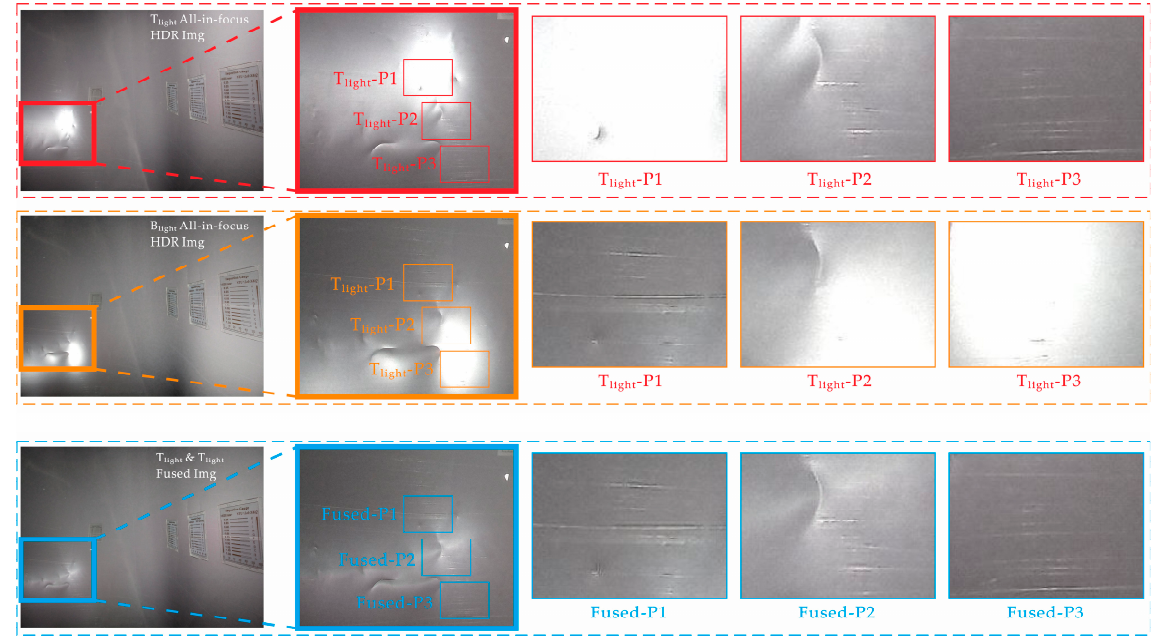
Figure 14. Comparisons of multifocus renderings.